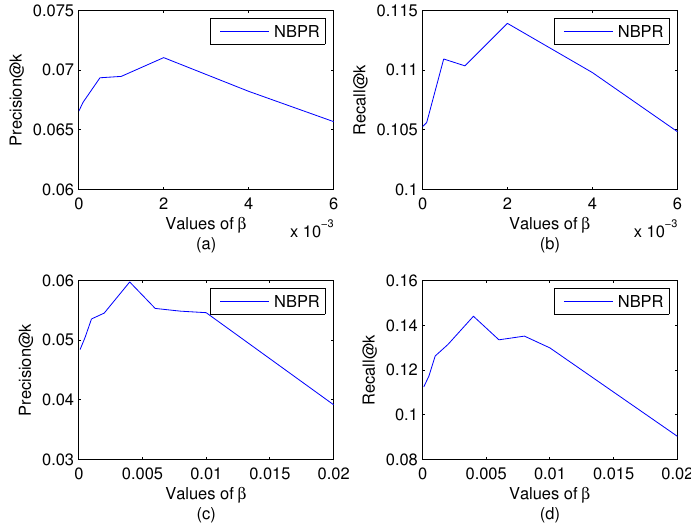
Figure 4. The recommendation performance of our method with the changes of parameter β in two LBSNs. ( a ) Precision@ k in the Gowalla data; ( b ) Recall@ k in the Gowalla data; ( c ) Precision@ k in the Brightkite data; ( d ) Recall@ k in the Brightkite